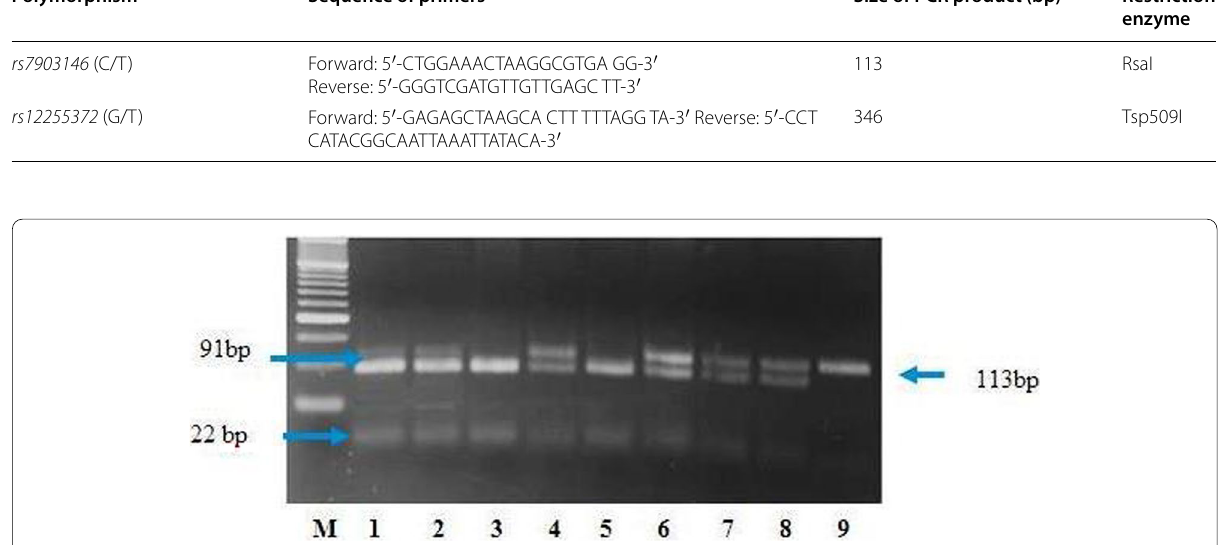
Fig. 1 A 3.5% agarose gel illustrating digestion of the PCR products with RsaI for detection of the rs7903146 polymorphism . Lanes 1–3 and 5: 4 samples with the C/C genotype (91 and 22 bp). Lanes 4, 6, 7, and 8: 4 samples with the T/C genotype (113, 91, and 22 bp). Lane 9: one sample with the T/T genotype (113 bp). Lane M: 50-bp ladder (Fermentas,